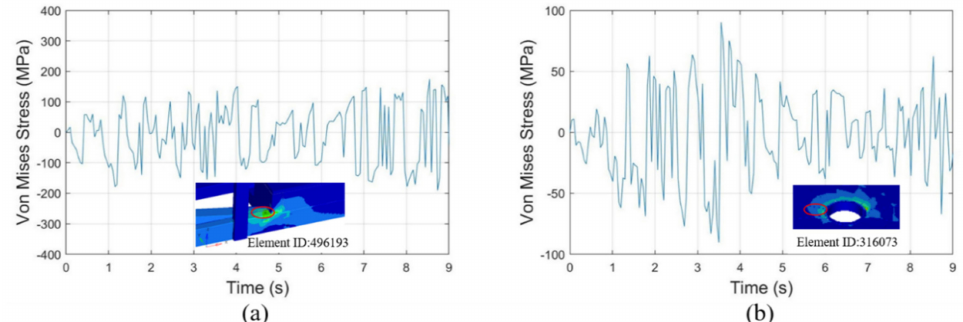
Figure 7. Von Mises stresses vs. time plots of ( a ) lower chassis connection, and ( b ) bogie mount central.